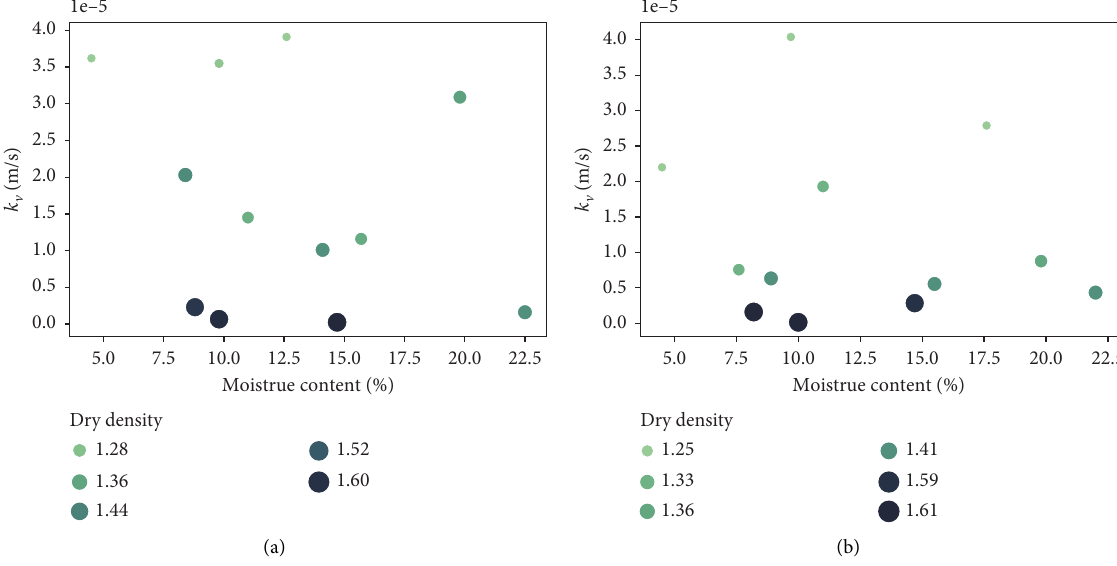
Figure 9: Scatter diagram between permeability coefficient and water content. (a) The intact loess. (b) The remolded loess.